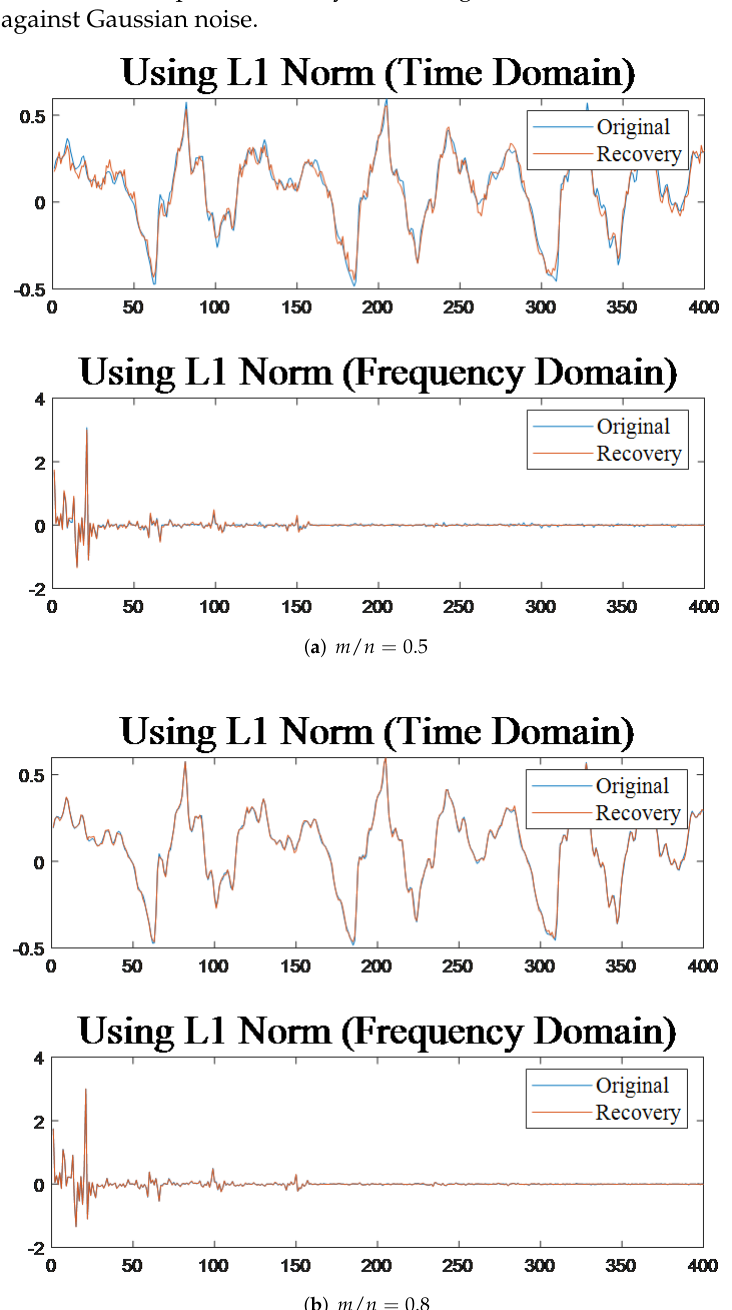
Figure 8. ( a ) Comparison of the original signal and the recovery signal in the case of a frame of signal and m / n = 0.5, the top is the time domain and the bottom is the frequency domain. ( b ) Comparison of the original signal and the recovery signal in the case of a frame of signal and m / n = 0.8, the top is the time domain and the bottom is the frequency